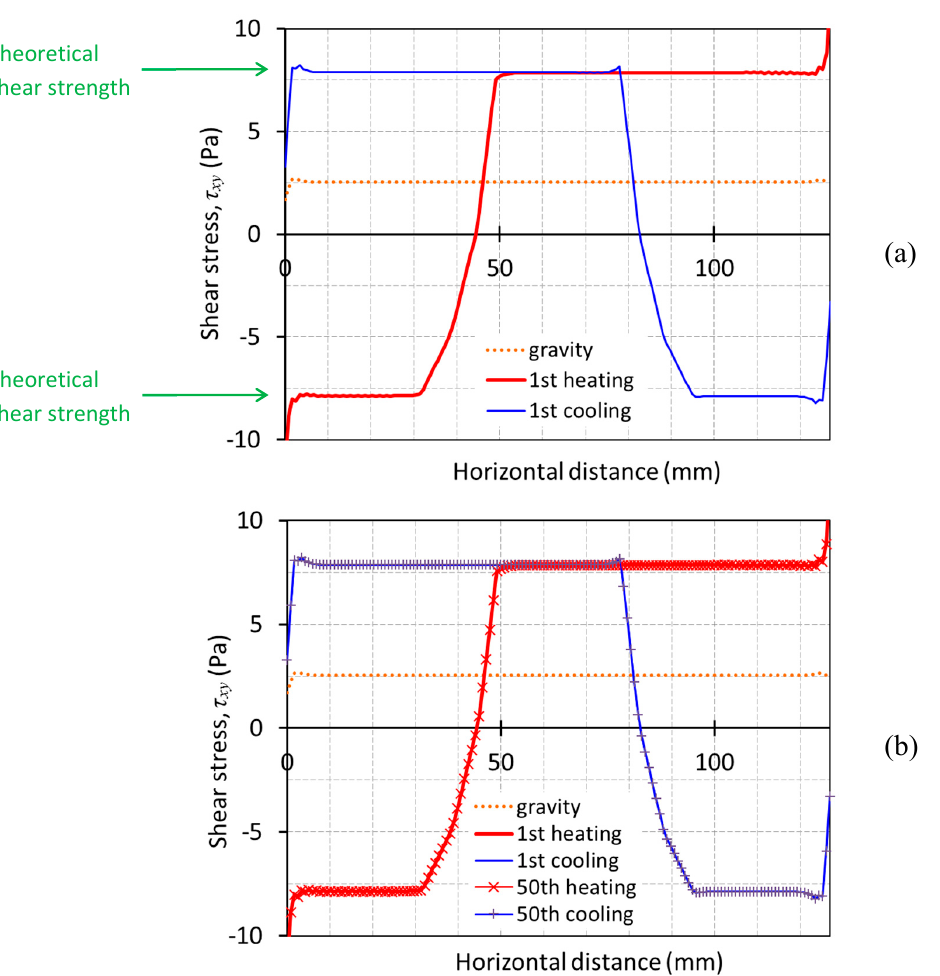
Figure 10. Distributions of interface shear stress ( τ xy ) at the acryl-wood interface. The presented results are based on ∆ T = 23 ◦ C in β = 5 ◦ slope with the parameters in Table 1. ( a ) and ( b ) are the same as in Figure